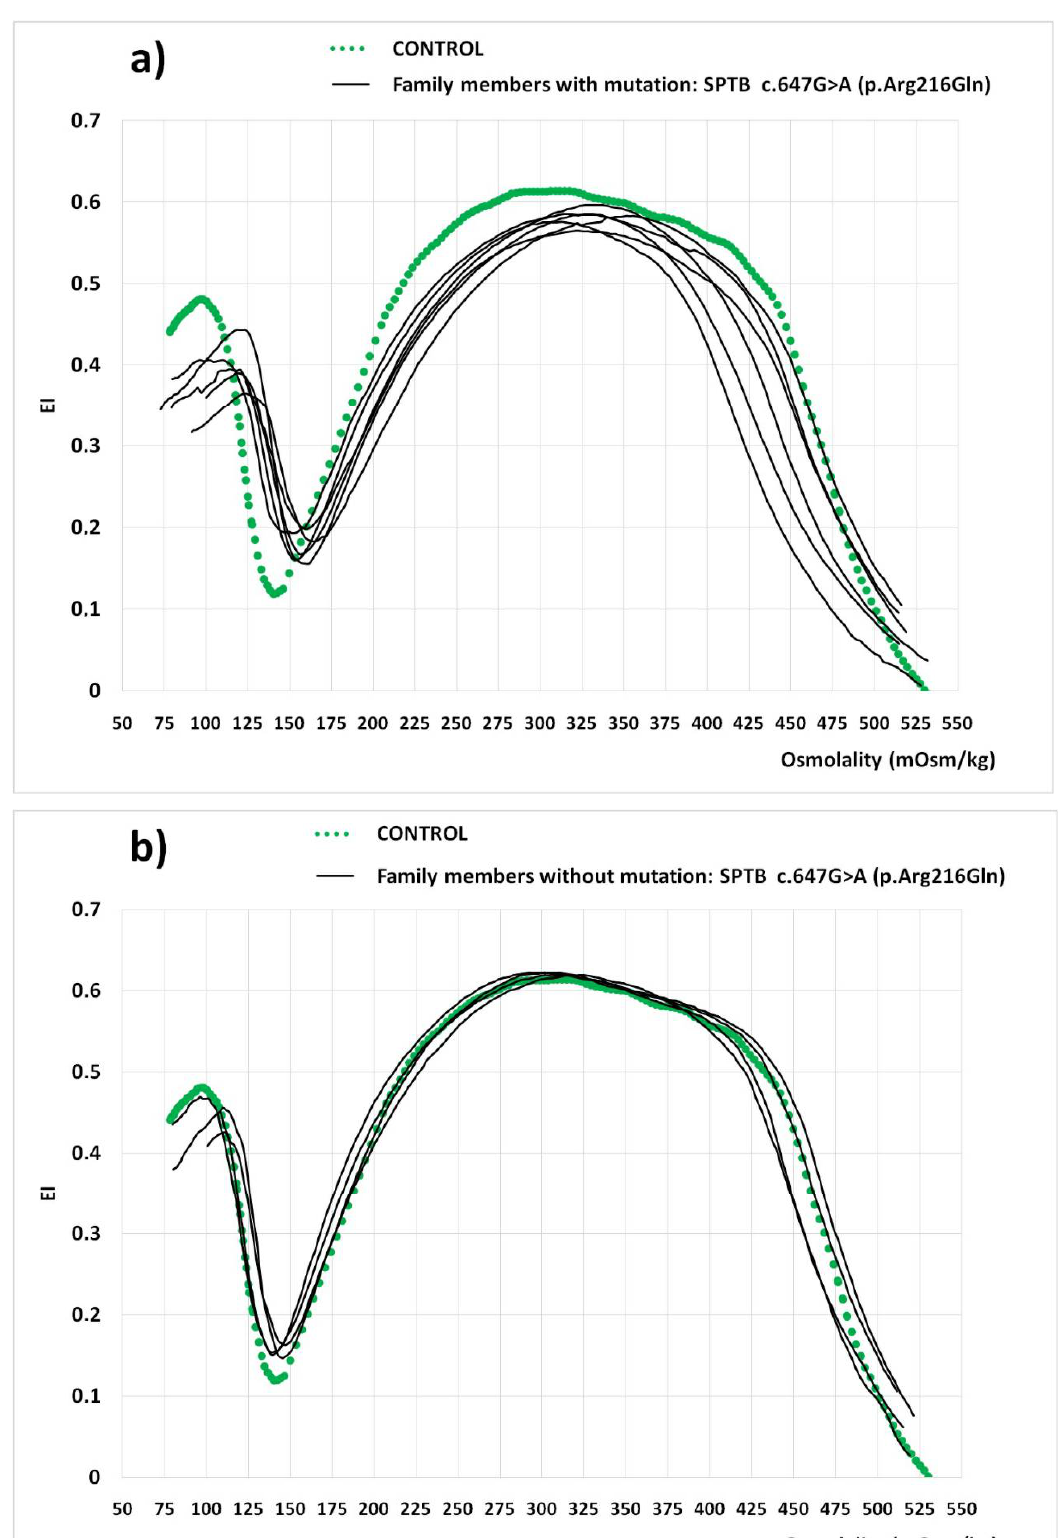
Figure 2. Osmotic Gradient Ektacytometry (OGE) curves. ( a ) Family members with HS (7 out of 11); ( b ) family members without HS (4 out of 11). Table 1. Clinical, hematological, and genetic data of the family members.